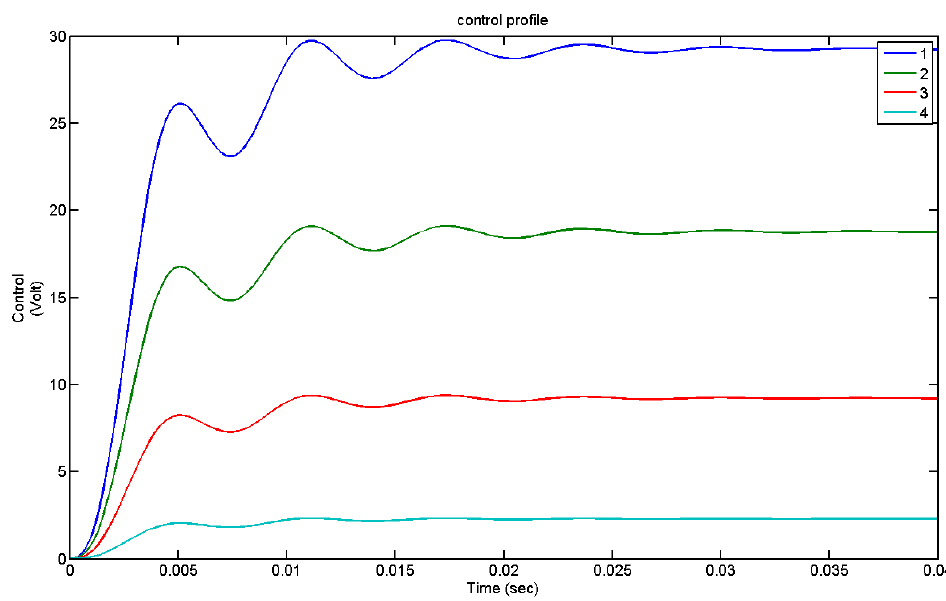
Figure 10. Piezoelectric voltages with reduced order controller for the first four nodes. The frequency response of the weighting function and matching model is shown in Figure 11. The graph of the function remains below unity so the controller archives robust performance for the given